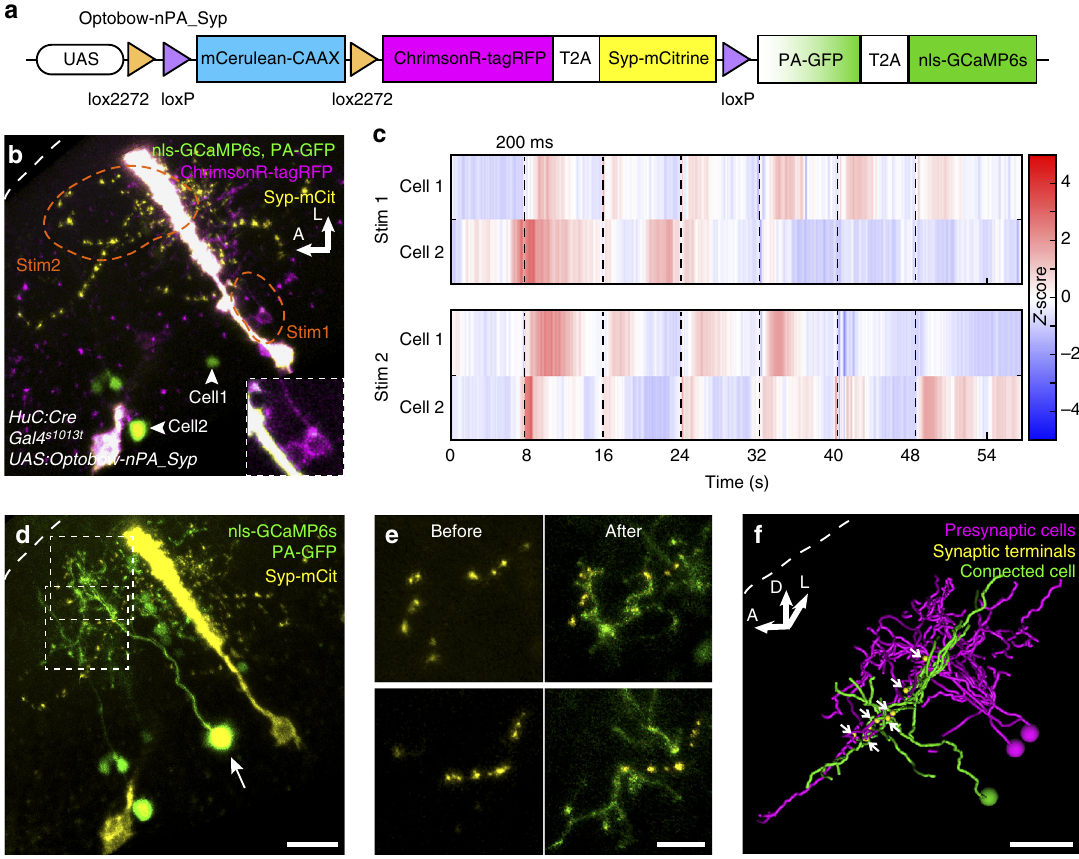
Fig. 4 Optobow-nPA_Syp reveals potential synaptic contacts. a In Optobow-nPA_Syp, ChrimsonR-expressing cells are co-labeled by Synaptophysin- mCitrine. b Tectal-speci fi c expression of Optobow-nPA_Syp. Cell bodies of two ChrimsonR-expressing cells ( magenta , close-up in lower right , Stim1) or neuropil regions (Stim2), respectively, were stimulated ( orange dashed line ), and activity of two nls-GCaMP6s-expressing cells ( arrowheads ) was monitored. Note that a radial glia cell overexpressing ChrimsonR-tagRFP and Syp-mCitrine appears in white . c Z -scores of calcium measurements for cell#1 and cell#2 during cell body (Stim1) or neuropil stimulations (Stim2). Photostimulation epochs of 200 ms are indicated by dashed lines . Cell#1 shows high response reliability. While cell#2 shows spontaneous activity during Stim1, its response correlates to neuropil stimulations suggesting that additional ChrimsonR- labeled cells were activated by Stim2. d Photoactivation of PA-GFP in cell#1 ( arrow ). Spectral unmixing was used to separate PA-GFP/GCaMP ( green ) from mCitrine signals ( yellow ; see Methods section). Scale bar, 20 µ m. e Close-up on single confocal slices of the regions marked in d before and after PA-GFP photoactivation. Scale bar, 10 µ m. f Three-dimensional fi lament reconstruction of presynaptic ( magenta ) and connected cells ( green ) in transverse view. Potential synapses, shown in yellow ( arrows ), are restricted to a single tectal layer. Scale bar , 20 µ